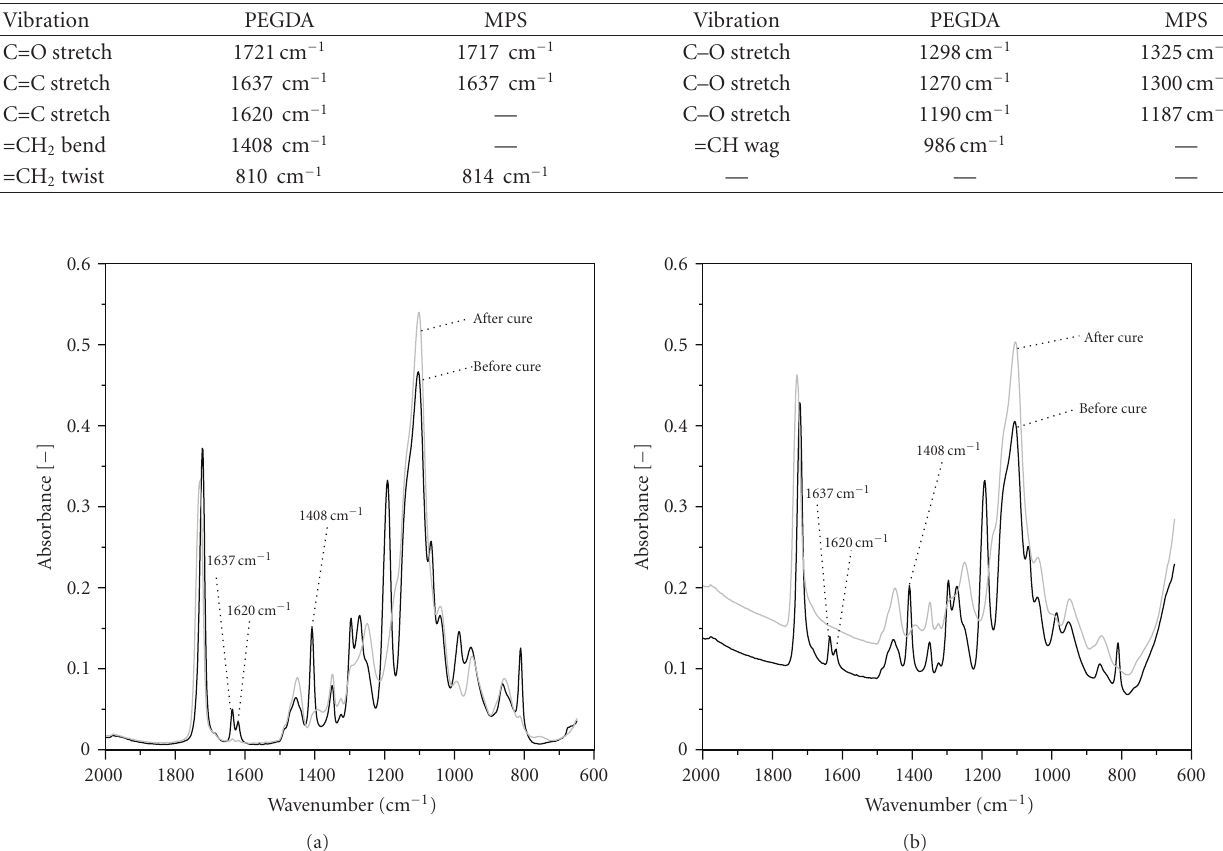
Figure 2: ATR FT-IR spectra of Sb:SnO 2 /PEGDA starting formulations before and after irradiation with 315 nm light. Sb = 13%; MPS / Sb:SnO 2 = 0 . 08 g/g. (a) 0.5vol% Sb:SnO 2 particles; (b) 10vol% Sb:SnO 2 particles.